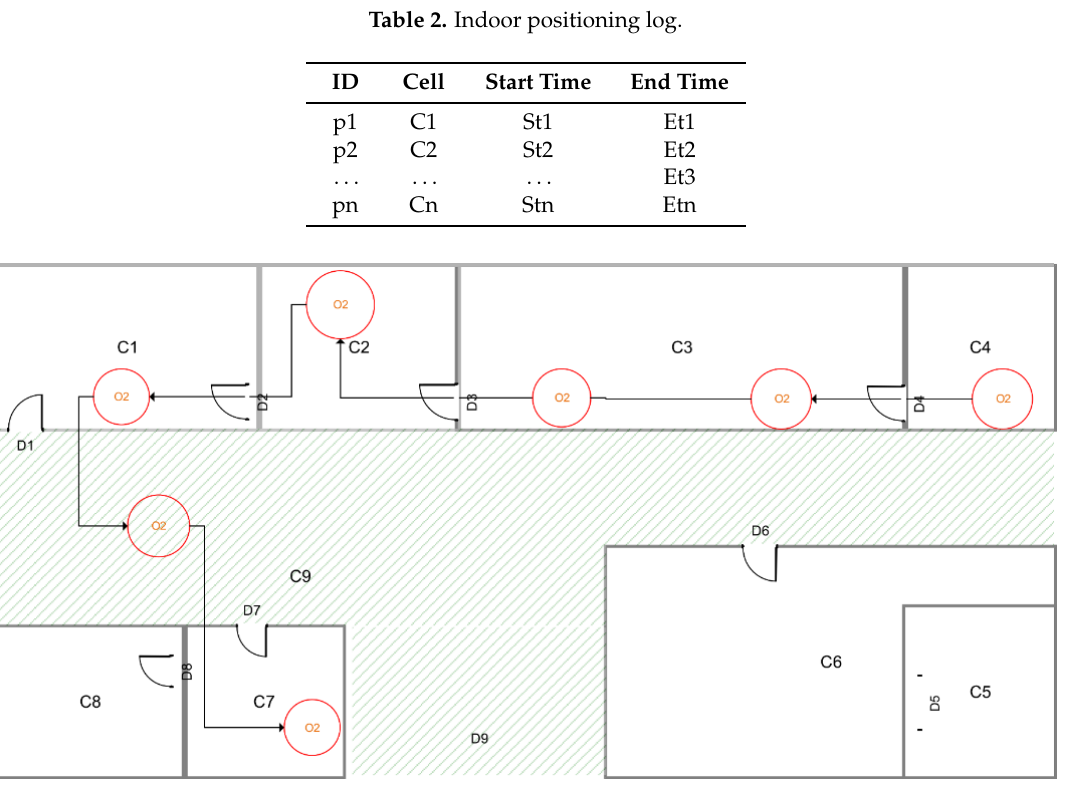
Figure 3. Record of a moving object’s travel through an indoor space.